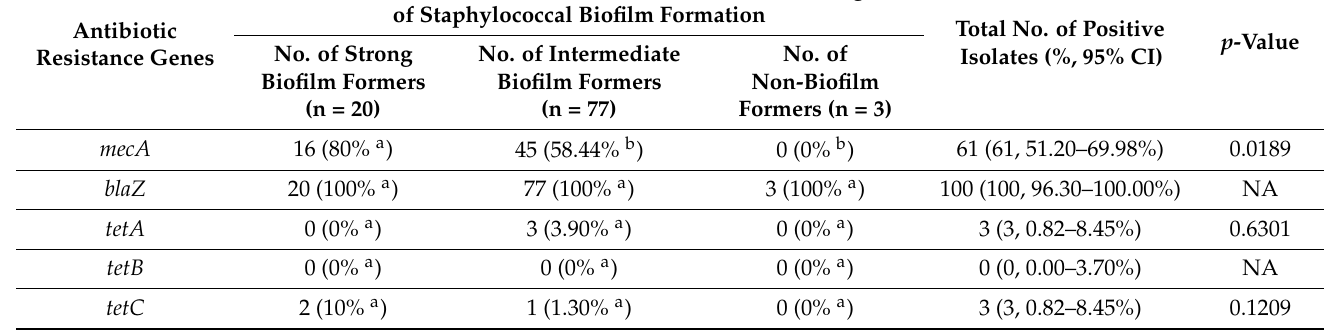
Table 5. Detection of antibiotic resistance genes in biofilm-forming S. aureus strains (n= 100) detected from different foods and hand swab